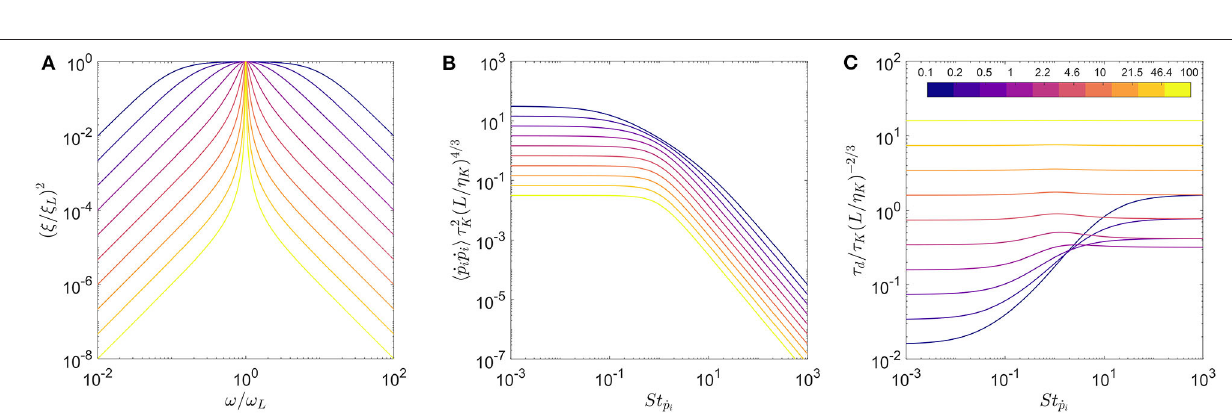
described by a bandpass filter peaked on ω L ∼ ǫ 1 / 3 L − 2 / 3 . In